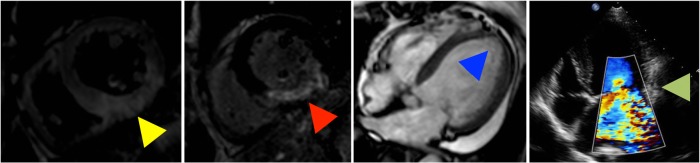
Examples for CMR findings of myocardial edema, necrosis, cardiac remodeling and echocardiography finding of severe mitral regurgitation (from left to right).The absence of detectable myocardial necrosis (red arrow head) is a key criterion for Grade-0 patients, for whom, myocardial edema (yellow arrow head) can be the only finding in the acute phase. Cardiac remodeling is defined as an expanded left ventricle (blue arrow head). Apparent mitral regurgitation (green arrow head) on the basis of cardiac remodeling is indicative of Grade 4.